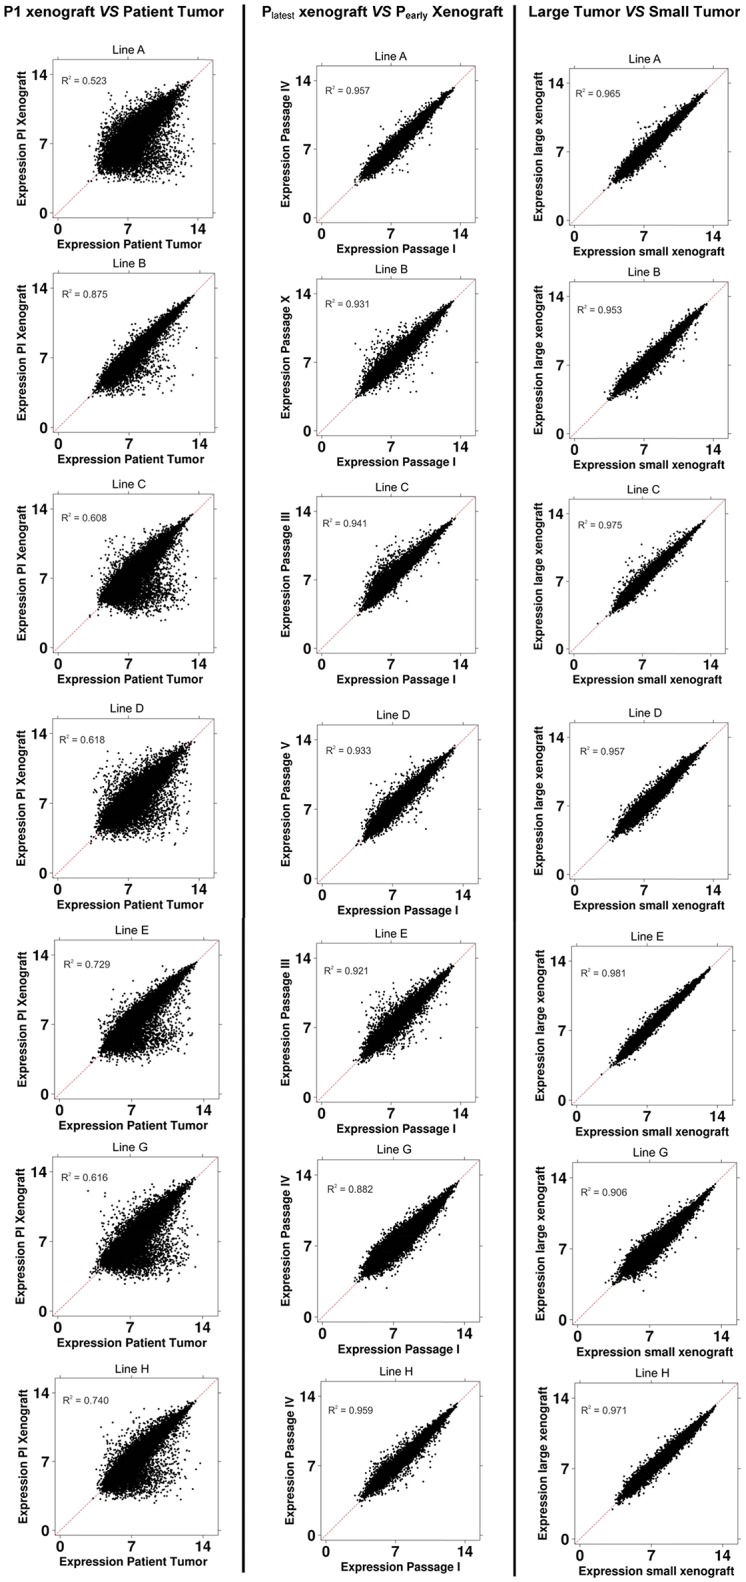
Scatterplot showing mRNA abundance comparisons for each established adenocarcinoma line.Comparisons were made between P1 xenograft vs patient tumor (left column), Platest
vs Pearly xenograft (middle column) and Large vs Small xenograft tumors (right column). Normalized expression levels for individual genes were used to plot the comparison. R2 values are included for each comparison. mRNA for lines F and I could not be extracted for all comparisons since mRNA degradation in the frozen tissue had occurred. Both samples had intact mRNA for the patient tumor but Line I did not have a matching later passage xenograft while Line F did not have a matching first passage xenograft. Both lines were included in statistical comparisons where the data was present.